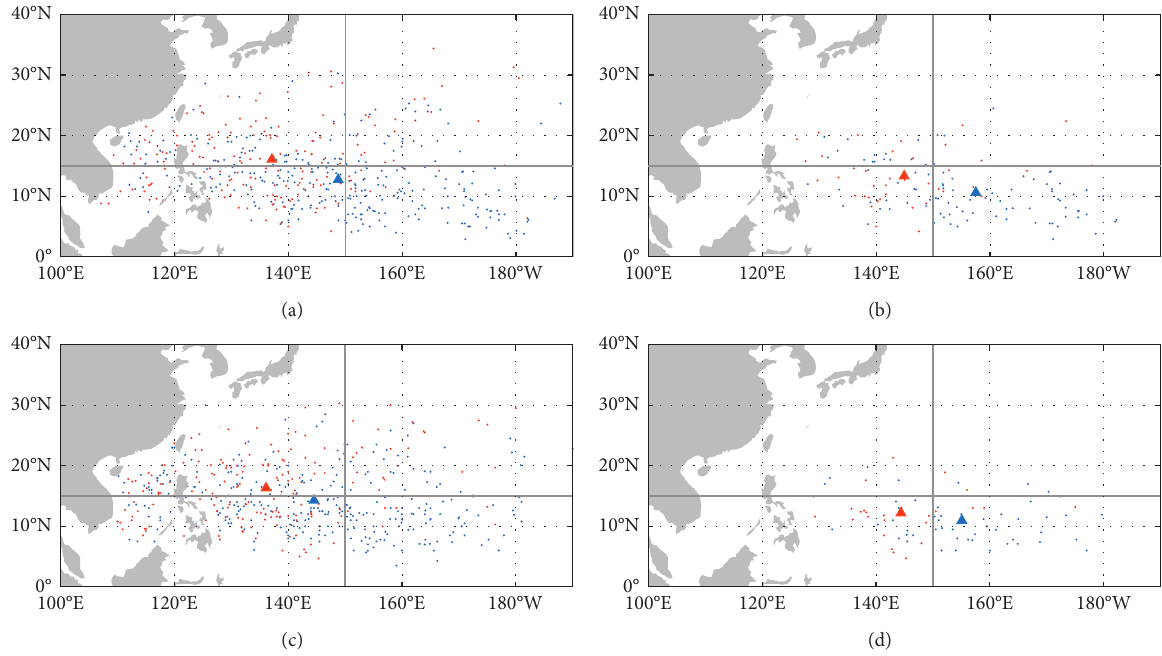
Figure 10: Genesis positions of (a) TCs in JTWC dataset, (b) C45 TCs in JTWC dataset, (c) TCs in CMASTI dataset, and (d) C45 TCs in CMASTI dataset during JASON season. The solid line denotes the boundary line of four quadrants. Blue and red triangles indicate the mean genesis positions of TCs in cold and warm years,